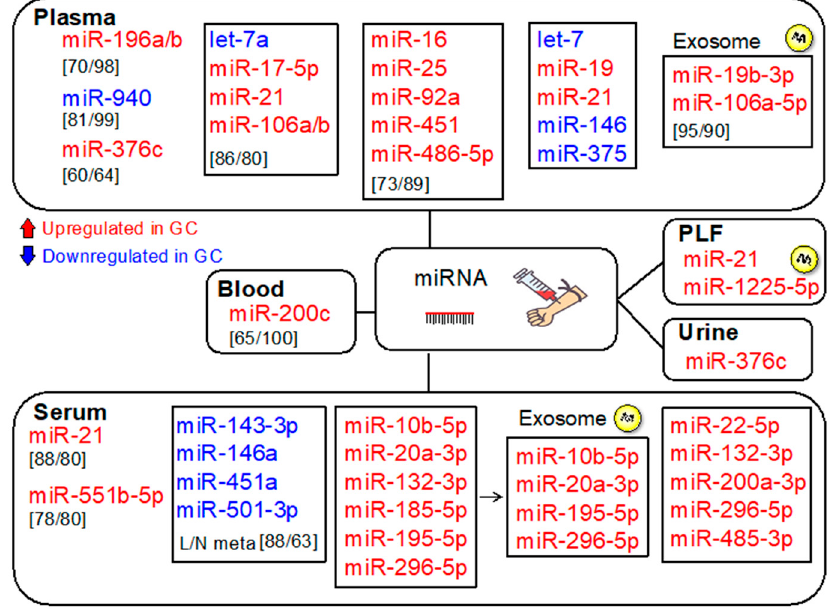
Figure 4. miRNAs potentially considered as diagnostic biomarkers for GC. Upregulated (in red) and downregulated (in blue) miRNAs are shown. Sensitivity and specificity are shown in square brackets. PLF: peritoneum lavage fluid.